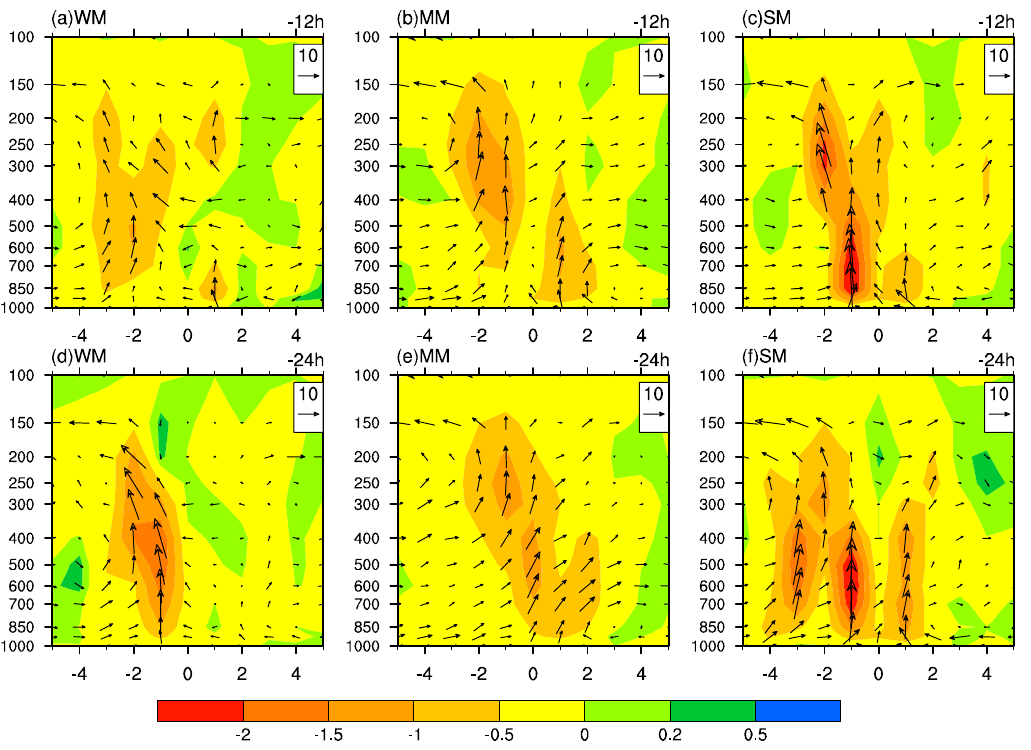
Figure 6. Composites of the meridional vertical circulation (vectors, m s − 1 ) and vertical speed (shaded, Pa s − 1 ) passing typhoon centers for three clusters at the monsoon peak time. ( a – c ) 12 h before landfall and ( d – f ) 24 h before landfall. ( a , d ) Cluster WM, ( b , e ) cluster MM, ( c , f ), and cluster SM.